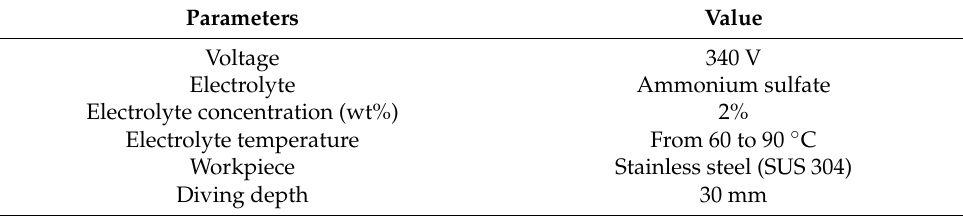
Table 1. Experimental